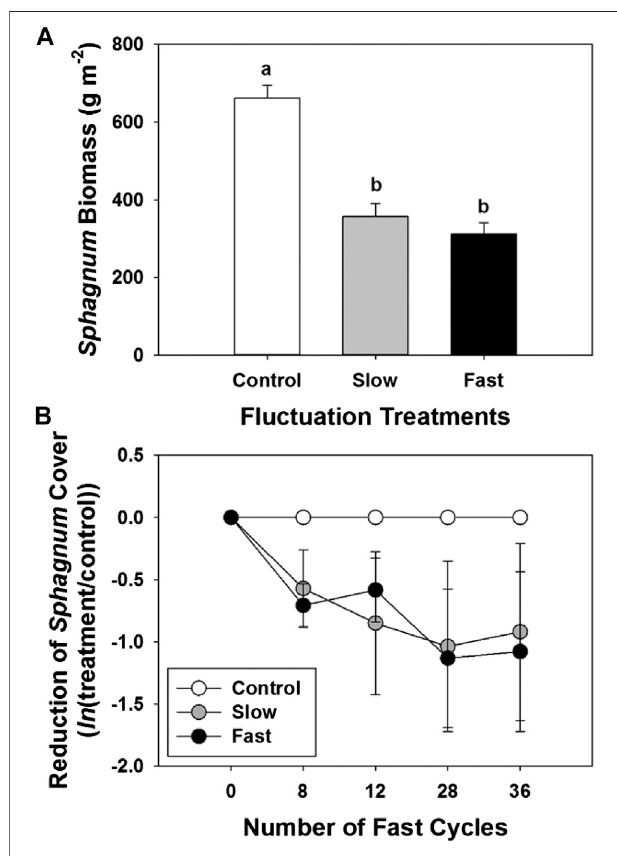
FIGURE 2 | (A) Sphagnum biomass, and (B) Reduction of Sphagnum - covered area during the experiment (response rate, ln (treatment/control)). Error bars denote standard errors. Letter denotes statistically signi fi cant differences between treatments (n (cid:2) 12, p < 0.05).